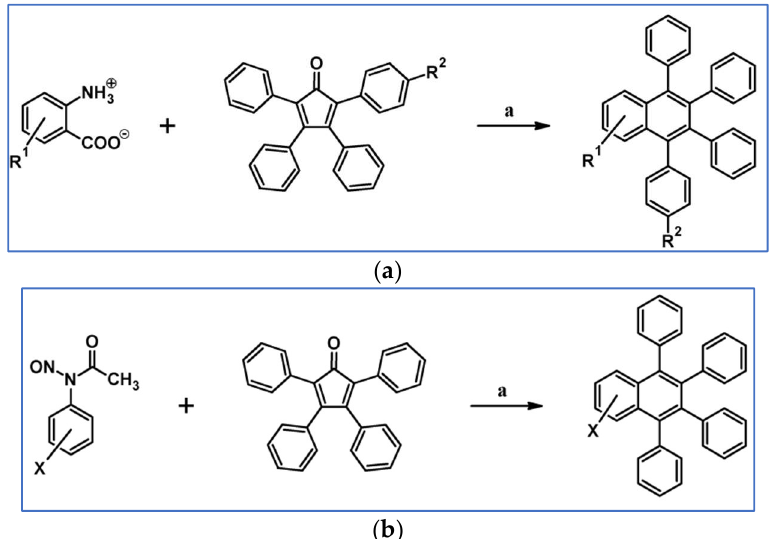
Scheme 226. Synthesis of naphthalene derivatives via DA cycloaddition of substituted